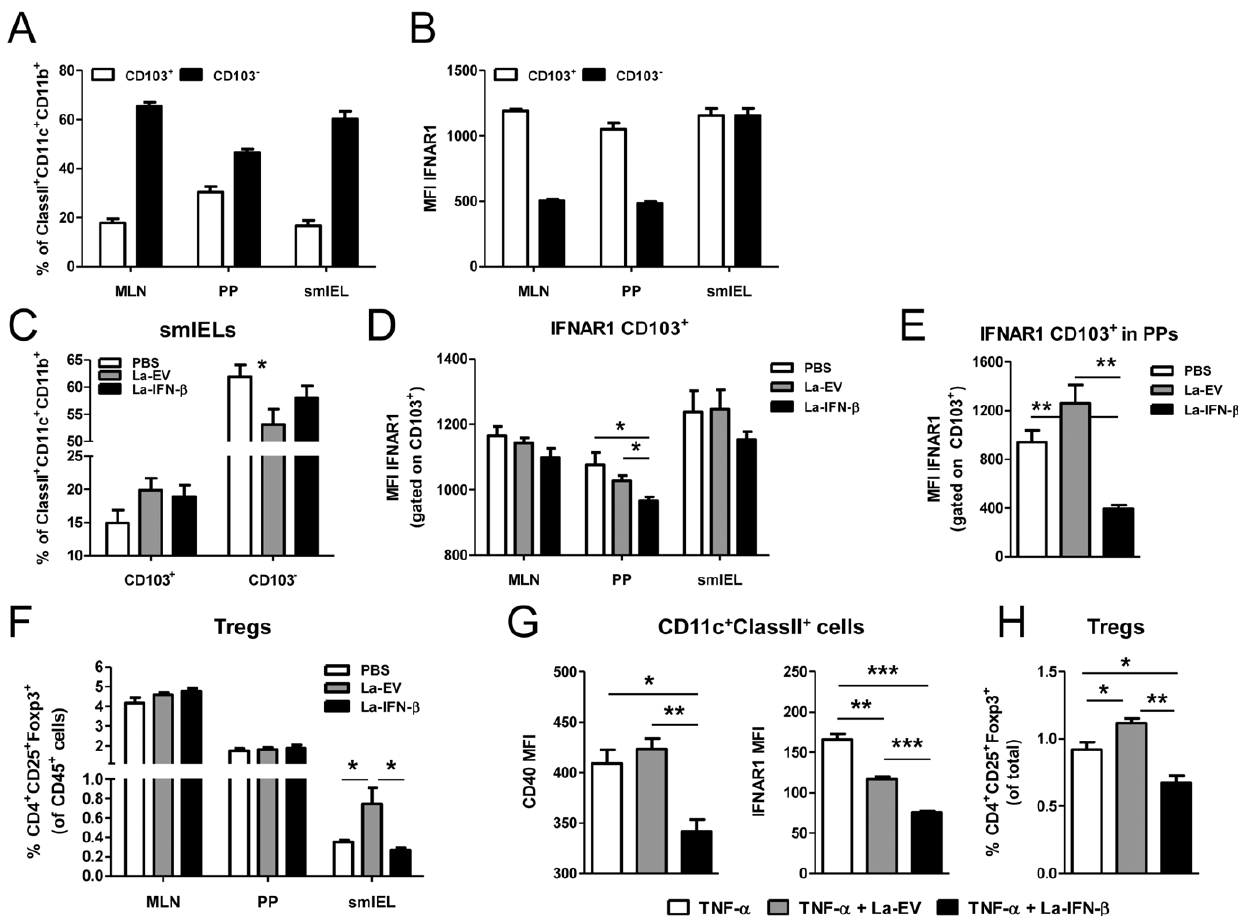
Figure 5. IFNAR1 is decreased on CD103 + DCs in the PPs of mice following treatment with La-IFN- b . ( A ) Percent distribution of CD103 + versus CD103 2 DCs in the MLNs, PPs and smIELs of wild-type mice (n=5) gated on CD45 + ClassII + CD11c + CD11b + cells. ( B ) IFNAR1 expression (mean fluorescence intensity, MFI) on CD103 + and CD103 2 DCs in the MLNs, PPs and smIELs from wild-type mice. ( C ) CD103 + and CD103 2 DC percentages in the smIELs of colitic mice pretreated with PBS, La-EV or La-IFN- b (n=5). ( D ) IFNAR1 expression (MFI) on CD103 + DCs in the MLNs, PPs and smIELs of colitic mice in the different treatment groups. ( E ) IFNAR1 expression on CD103 + DCs in the PPs of healthy mice following three consecutive days of gastric gavage with PBS, La-EV or La-IFN- b . ( F ) Cells were isolated from colitic mice pretreated with PBS, La-EV or La-IFN- b (n=5) from the MLNs, PPs and smIELs and stained for the presence of Tregs, which were gated as CD45 + CD4 + CD25 + Foxp3 + . The graph shows the % Tregs present in the CD45 + population. ( G, H ) BMDCs from wild-type mice were matured with TNF- a (50 ng/ml), TNF- a + La-EV or TNF- a + La-IFN- b (100:1 ratio, bacteria:BMDCs) for 2 d. The mature BMDCs were then co-cultured with CD3/CD28 (1 m g/ml) activated splenocytes for 7 d (1:2 ratio, BMDCs:splenocytes). Following co-culture, DCs (gated as ClassII + CD11c + ) were stained for CD40 and IFNAR1 expression ( G ) and the percent Tregs (CD4 + CD25 + Foxp3 + ) was determined ( H ). The data is represented as the mean 6 SEM. * p , 0.05, ** p , 0.01, *** p , 0.001.